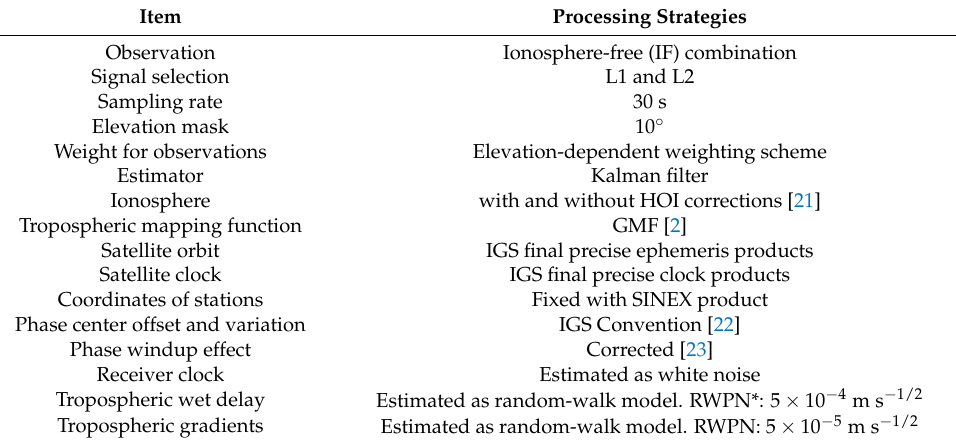
Table 1. Processing strategies of precise point positioning (PPP) for tropospheric parameters retrieval.